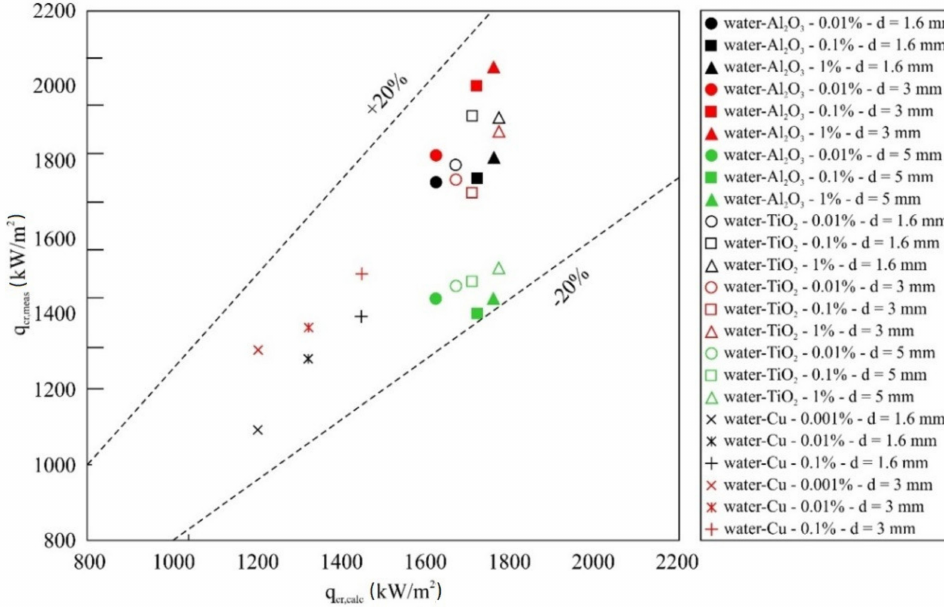
Figure 13. Comparison of the experimental data with predictions.